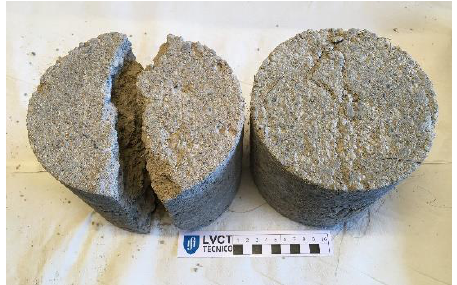
Figure 5. Example of CBGM specimens, without CF ( left ) and with CF ( right ), after the indirect tensile strength test.